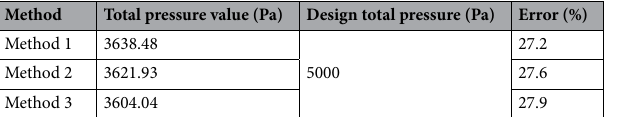
Table 6. Comparison of total pressure of impeller.